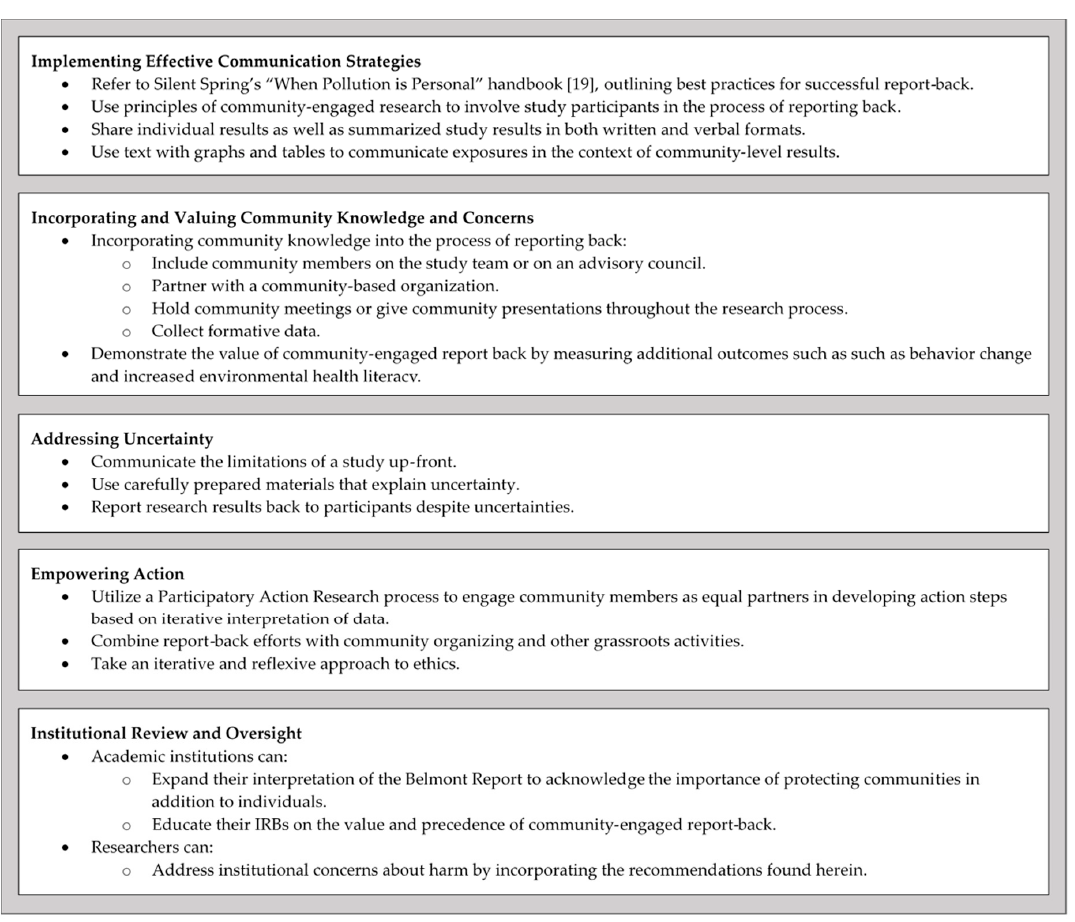
Figure 3. Recommendations to Improve the Practice of Reporting Back Research Results. To improve the practice of reporting back, researchers and academic institutions may consider taking action in these five